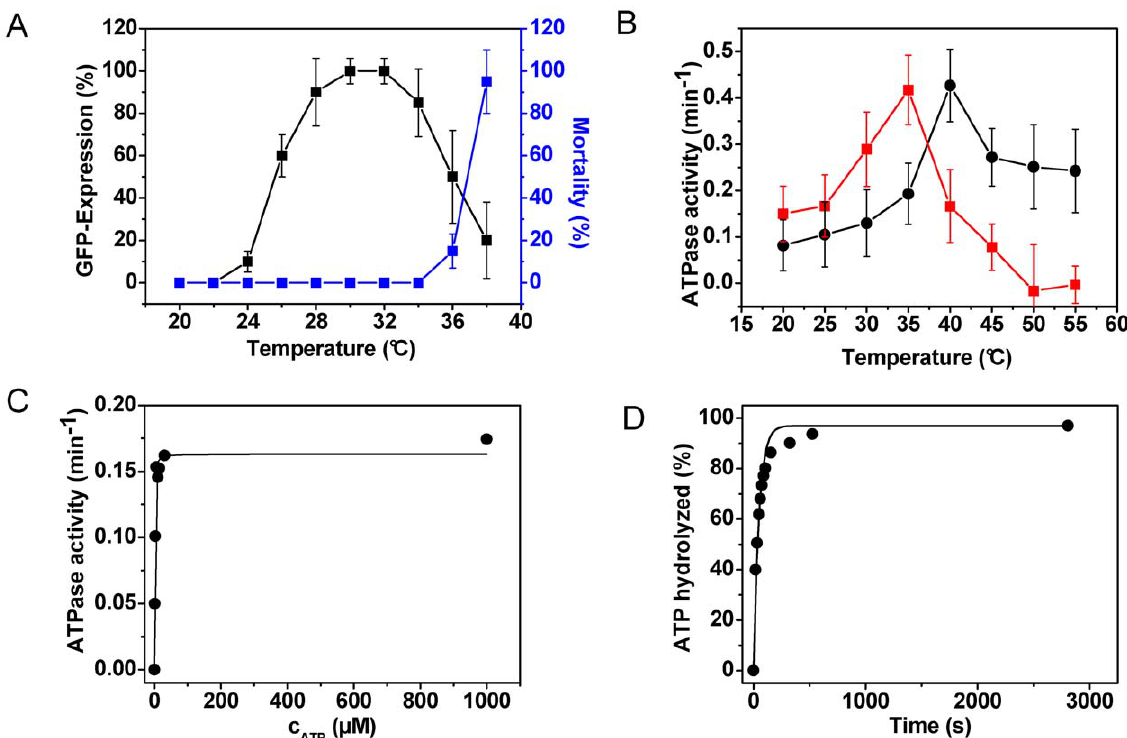
Figure 1. Characterization of CeHsc70. ( A ) The induction of the heat-shock response (black squares, left ordinate) was analyzed by exposing a hsp-70 ::GFP containing C. elegans strain to different temperatures for two hours and scoring after a recovery time of twelve hours. For this experiment nematodes at YA stage were used. The worms were grown at 20 u C before shifting them to the respective heat-shock temperature. The percentage of mortality in percent of deceased animals (blue squares, right ordinate) was determined from these samples as well. The values presented are an average of three independent experiments and the error bars represent the standard deviation. ( B ) The dependence of the ATPase rate of CeHsc70 (red squares) and HsHsc70 (black circles) was determined under steady-state conditions as described in the Materials and Methods section. The N values represent the mean of three replicates with the corresponding standard deviation given as errors. ( C ) Determination of the K M -value of ) for ATP in standard buffer at 25 u C. Steady-state ATPase activities were determined for CeHsc70 at different ATP concentrations. The data CeHsc70 ( were analyzed as described in the Materials and Methods section. ( D ) Single-turnover measurement of 20 m M CeHsc70 ( ATP in standard buffer at 25 u C. Data were analyzed as described in the Materials and Methods section.